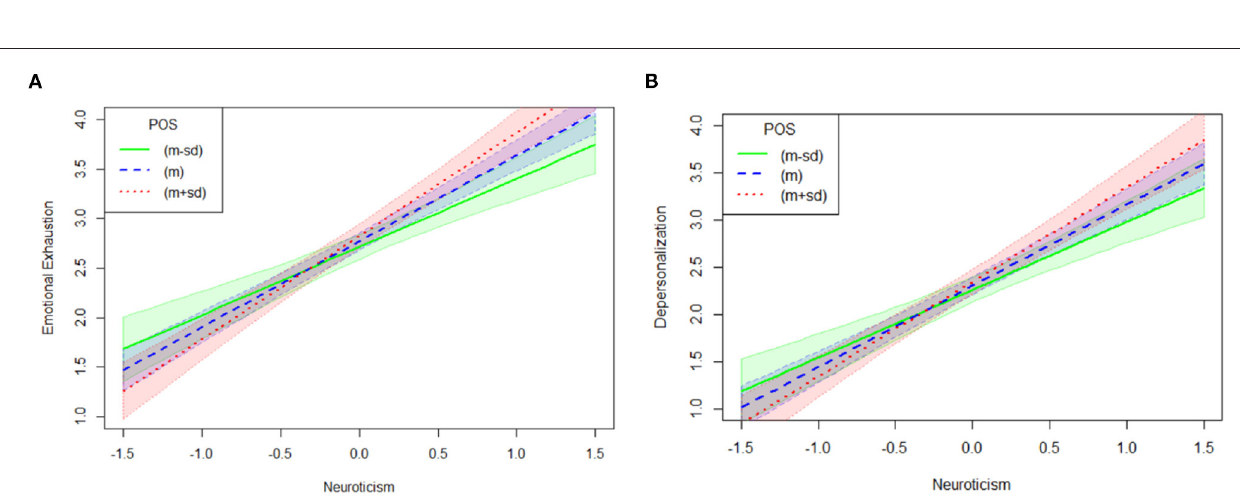
Frontiers in Public Health |